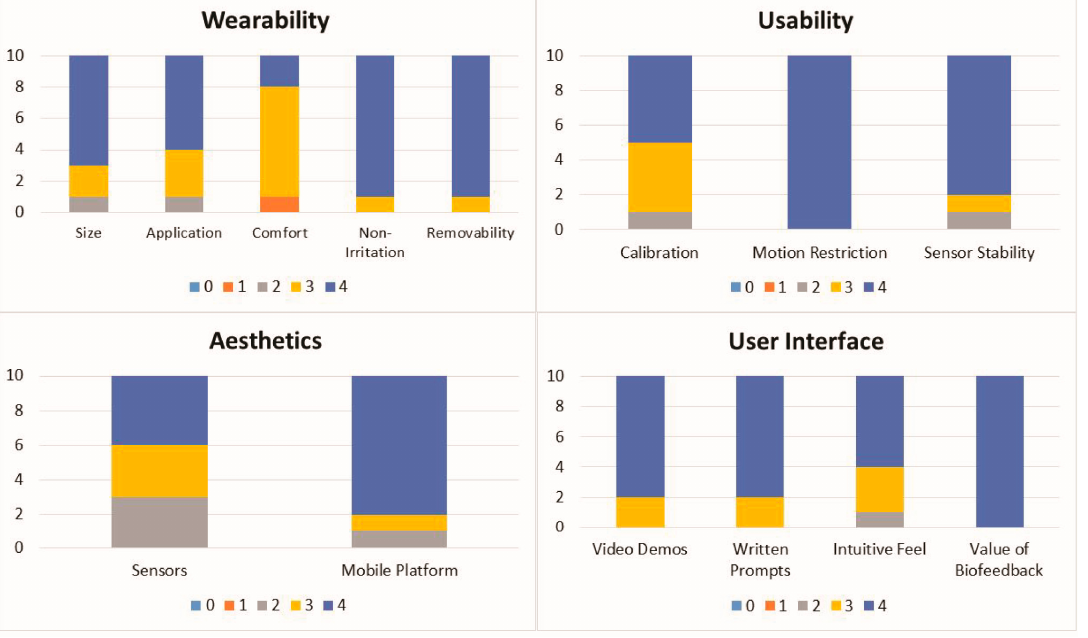
Figure 5. Frequency bar graph of the ASQ survey results. 4. Discussion The IMU-based knee angle measurement system provided an accurate and repeatable measure of human knee joint motion during physical therapy exercises. Validation with OptiTrack showed that the IMU measurements had an RMSE of less than three degrees of the “gold standard”, with moderate to good correlation between the two for all measured exercises. The Bland-Altman mean difference ranges from − 1.7 to 3.2 degrees and the limits of agreement were the largest for the SAQ exercise ( − 3.0 degrees and 9.5 degrees). These results are consistent with previous reports that have used optical tracking systems, electromagnetic tracking systems, or potentiometers as benchmarks [27,31–37].